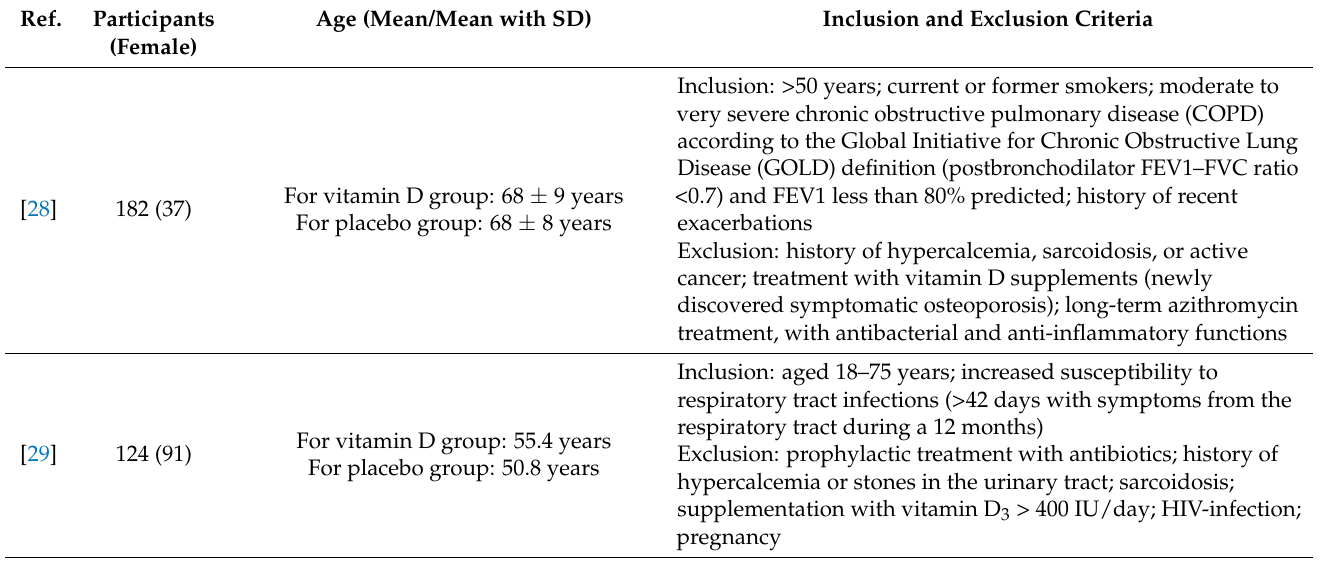
Table 3. The descriptions of the studied populations within the studies included in the systematic